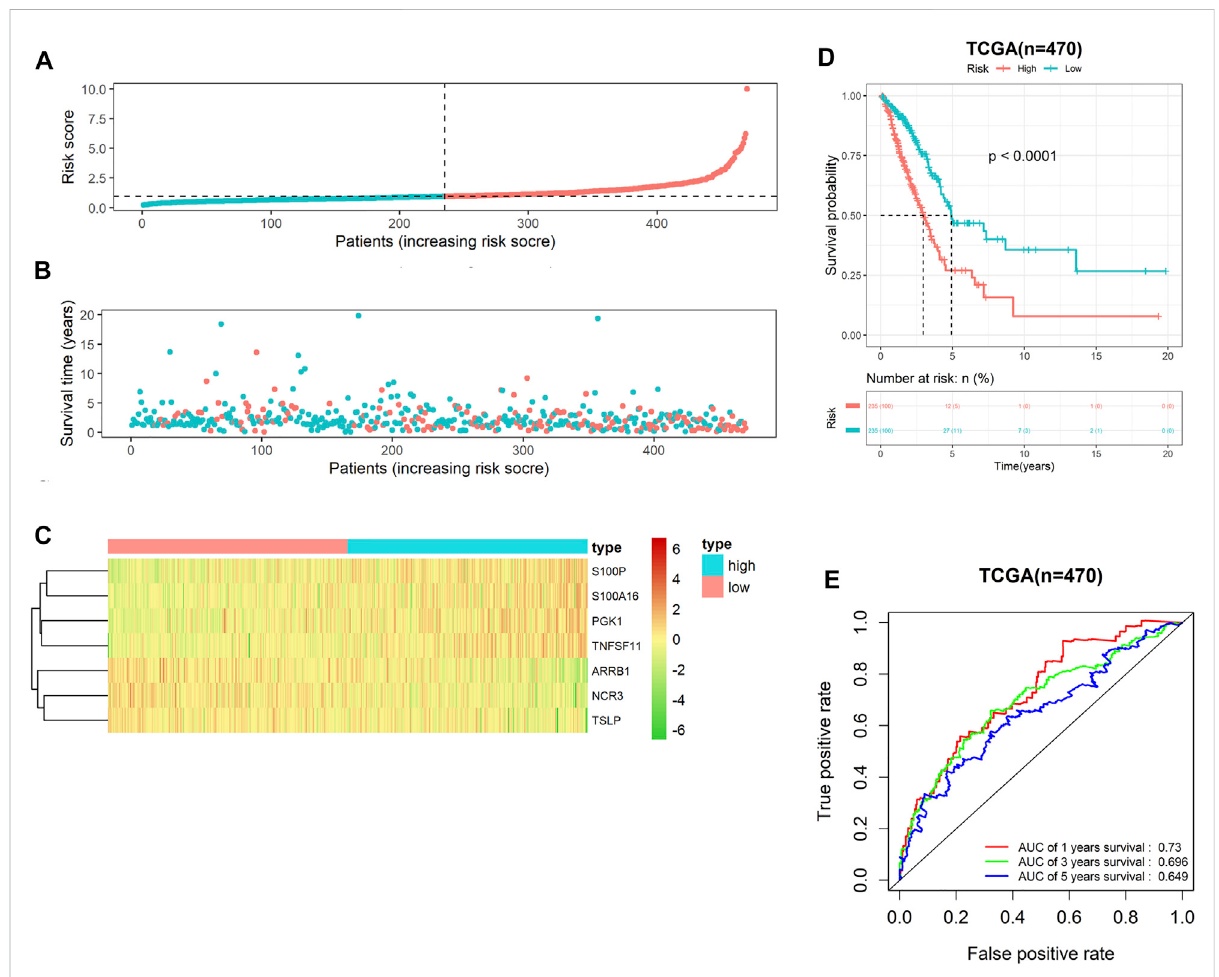
FIGURE 2 Performance assessment of the 7-gene signature in TCGA-LUAD cohort (A) Riskscore arrangement of LUAD patients; (B) Riskscore chart of patientsinhigh-andlow-riskgroups; (C) Distributionofsurvivalstatusofpatientsintworiskgroups; (D) Survivalcurvesofpatientsintworiskgroups; (E) ROC curves of 1-, 3- and 5-year survival of LUAD patients predicted by the 7-gene